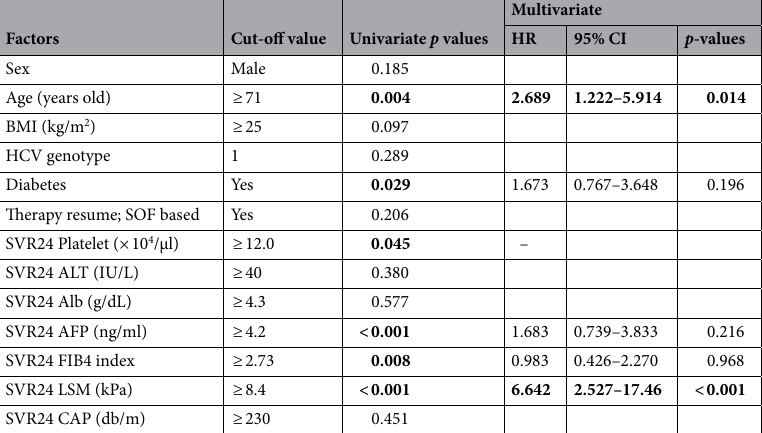
Table 3. Predictive factors at SVR24 for occurrence of HCC after SVR. BMI Body mass index, HCV Hepatitis C virus, SOF Sofosbuvir, SVR24 Sustained viral response at 24 weeks, AST Aspartate transaminase, ALT